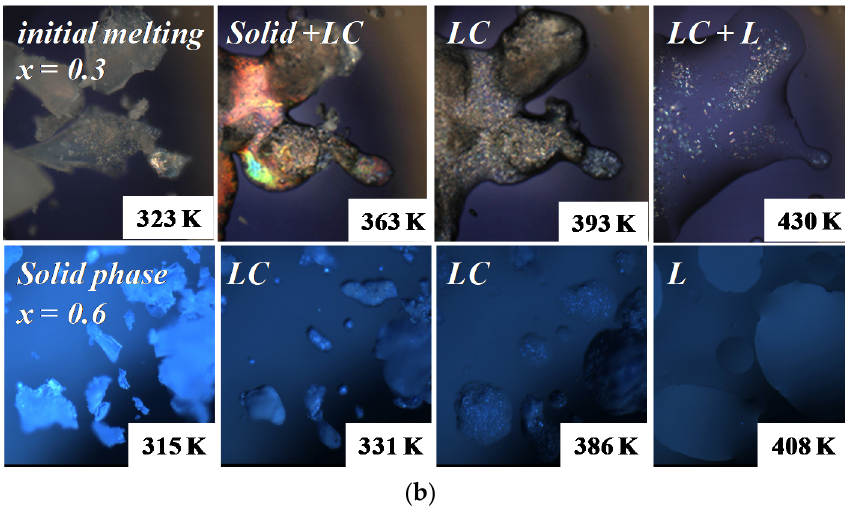
Figure 4. ( a ) Micrographs for cholesterol + phytosterol mixtures and for ( b ) cholesterol + γ -oryzanol mixtures (LC = Liquid Crystal; L = Liquid). x = cholesterol molar composition.